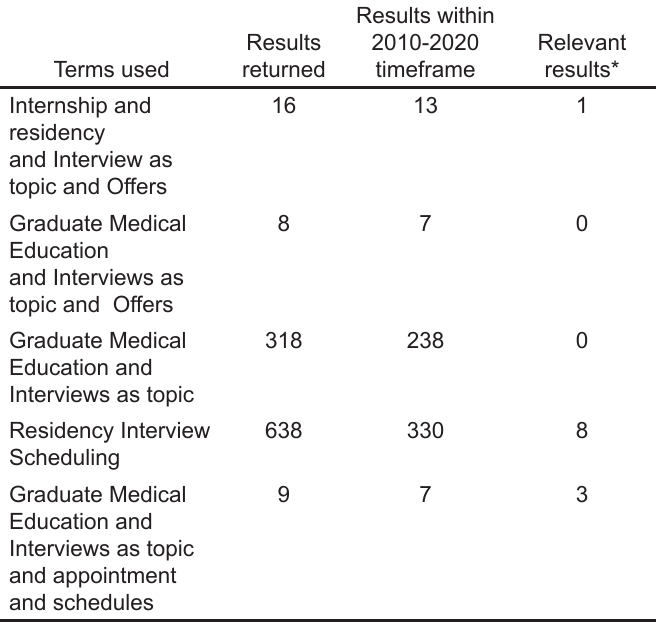
Table 1. Search strategy and results regarding the current system of offering interviews to residency